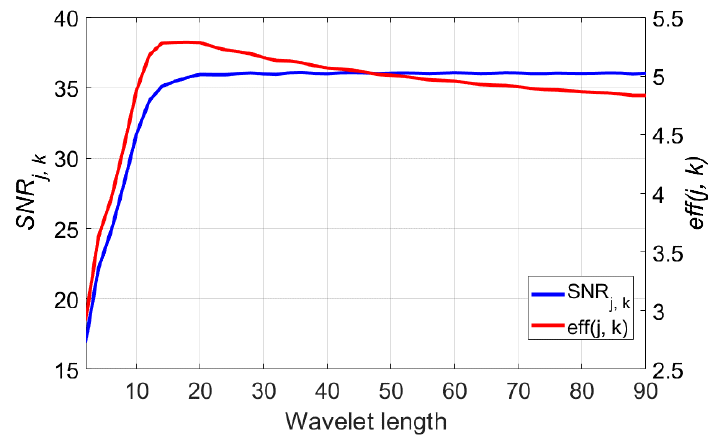
Figure 6. Denoising performance of the wavelet length (2 to 90), blue plot denotes 𝑆𝑁𝑅 𝑗,𝑘 values and red plot denotes 𝑒𝑓𝑓(𝑗, 𝑘) . The used decomposition level 𝑗 is 7.